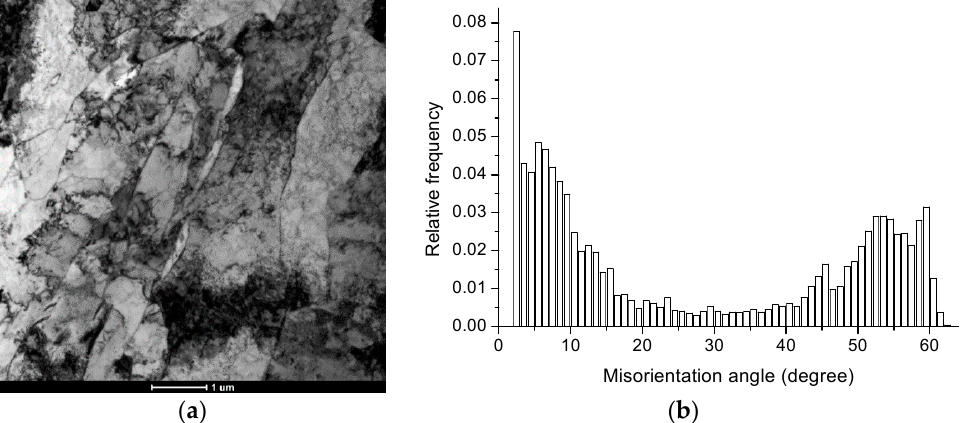
Figure 2. ( a ) The bright field TEM image shows the acicular ferrite of X70 steel, and ( b ) The distribution of misorientation angles showing a “bimodal” distribution in two areas of 2°~15° and 45°~60°.